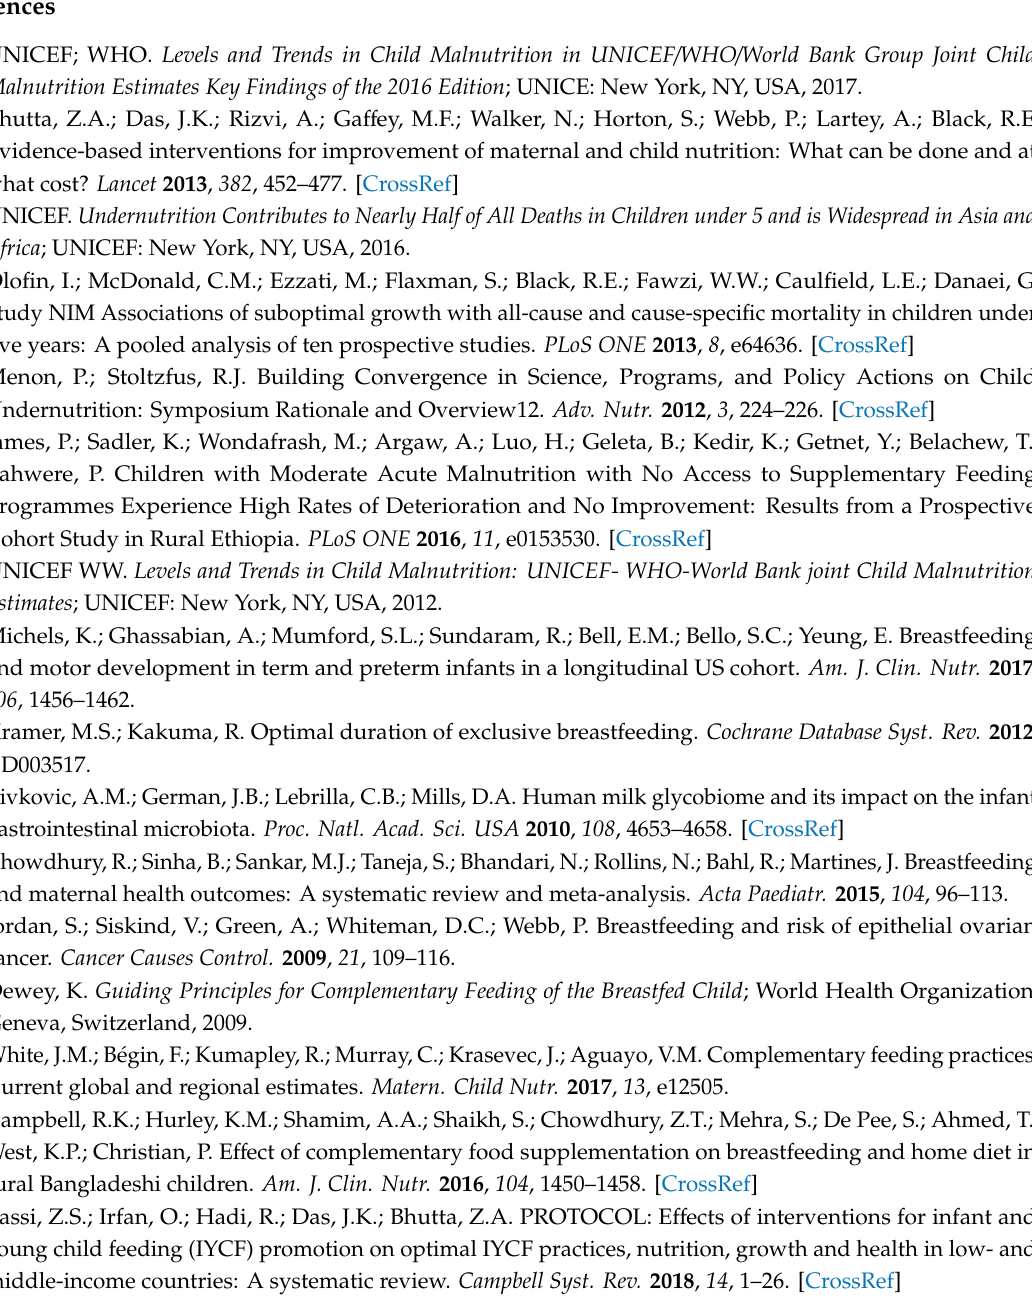
meta-analyses; Table S3: Supplementary feeding meta-analyses; Table S4: Single study outcomes; Table S5: Search strategy; Table S6: Characteristics of included studies; Table S7: Summary of findings table of breastfeeding education; Table S8: Summary of findings table of complementary feeding; Table S9: Summary of findings table of supplementary